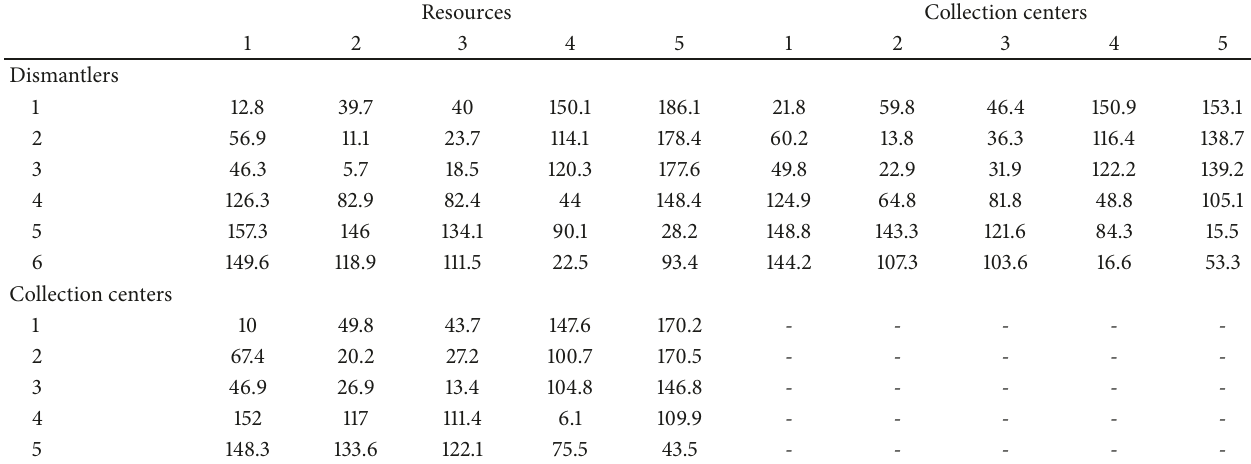
Table 12 indicates the follow-ing: (1) All the ELVs from the five sources are transported to collection centers 1, 2, 4, and 5, while the quantities of trans- portation between the ELV sources and collection centers 3 and 6 are